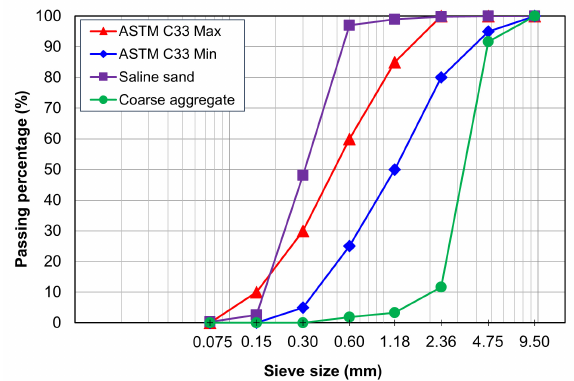
Fig. 1. The grain size distribution of saline sand and coarse aggregate.